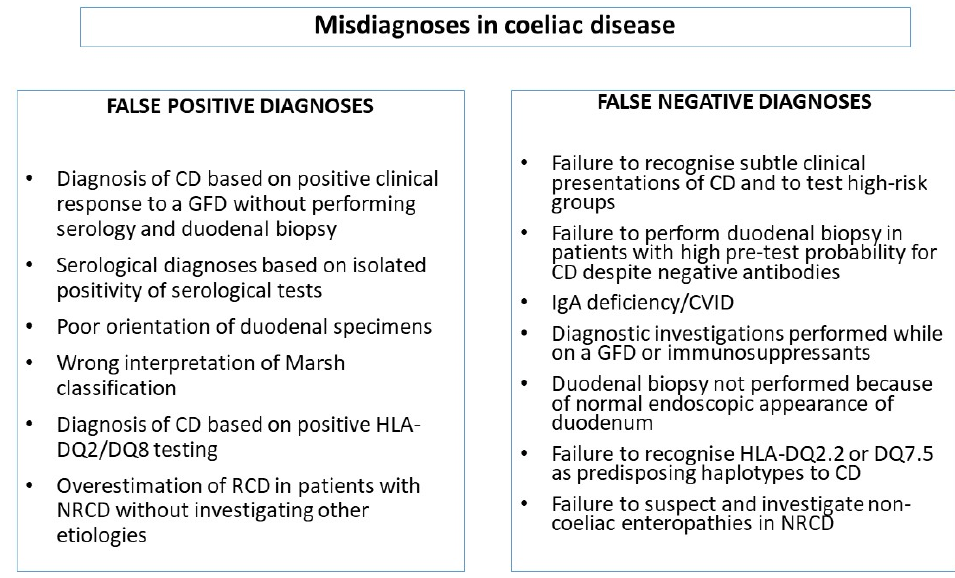
Figure 1. Classification of diagnostic errors in coeliac disease. CD: coeliac disease; GFD: gluten-free diet; NRCD: nonresponsive coeliac disease; RCD: refractory coeliac disease; AGA: anti-gliadin antibodies; DGP: antibodies against deamidated gliadin peptides.